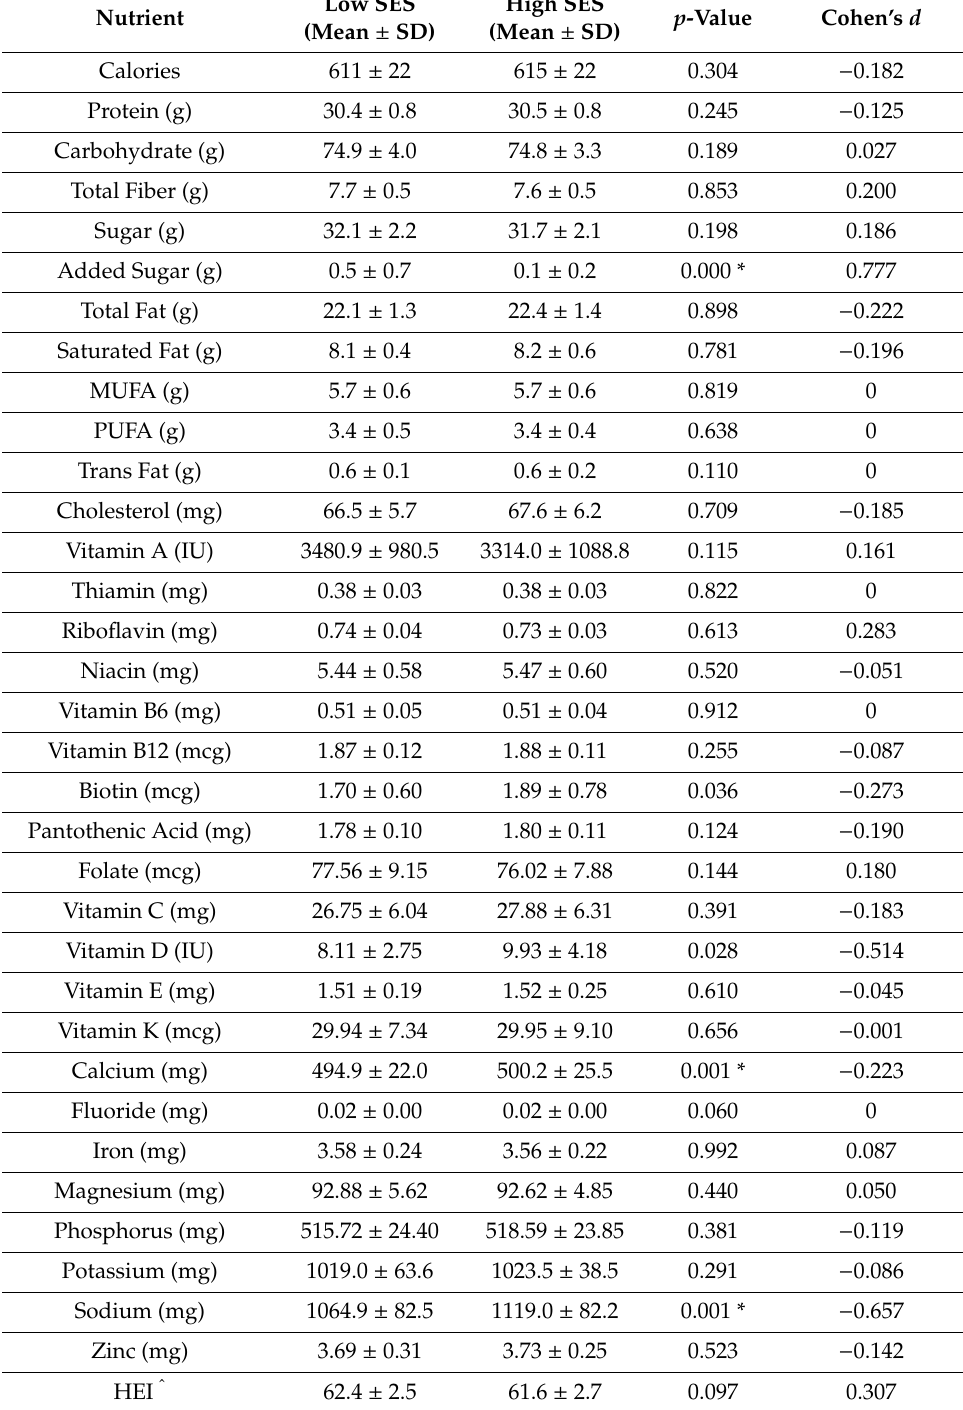
Table 1. Comparison of nutrient content and dietary quality (DQ) by socioeconomic status